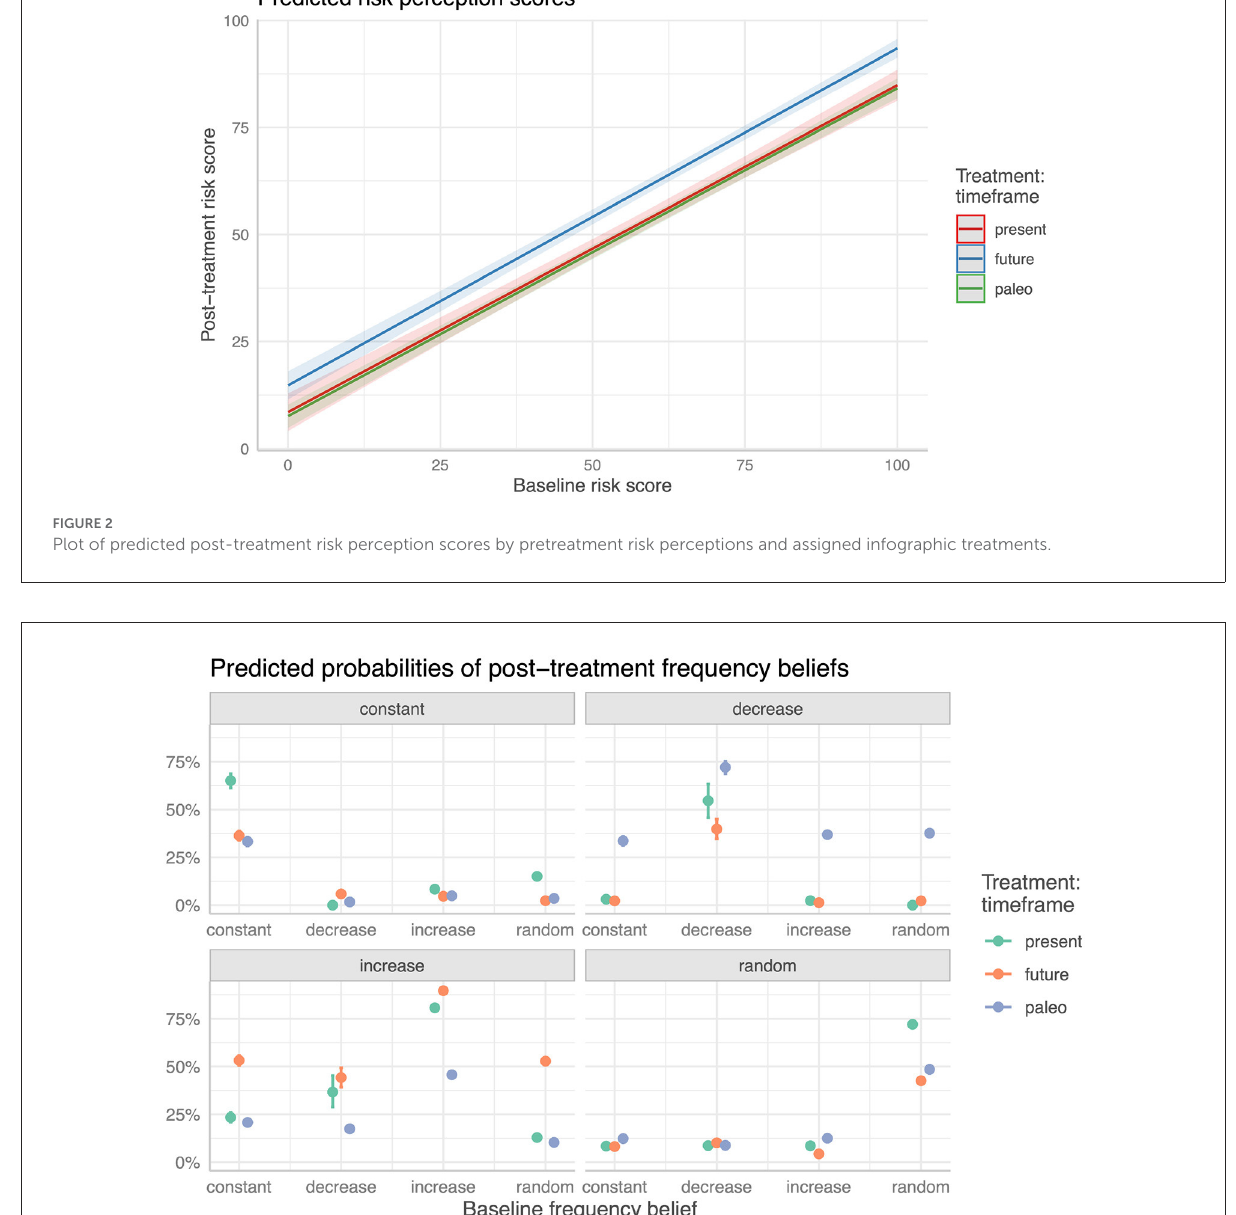
the effect of the control ( p > 0.1). For frequency beliefs, future and paleo formats were found to have larger effects (i.e., larger deviations from the mean probability of each response) than the present-only format (F ratios of 320.21 [future], 253.40 [paleo], and 187.83 [present]; all significantly different from the mean response, p < 0.0001). Contrasts for present—future (F = 9.35,